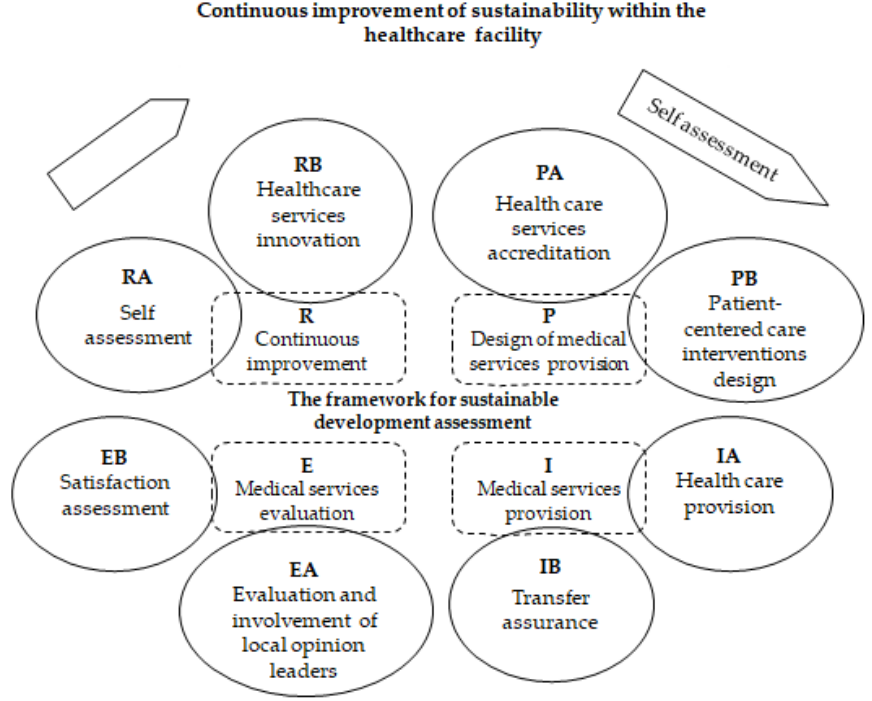
Figure 2. The sequence and interaction of the H-S core activities that make up the quality cycle.